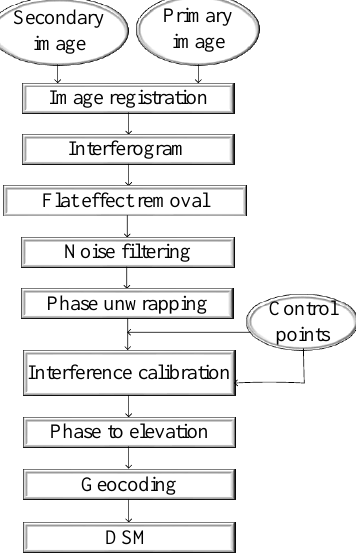
Figure 2. The flow chart of generation DSM using airborne InSAR